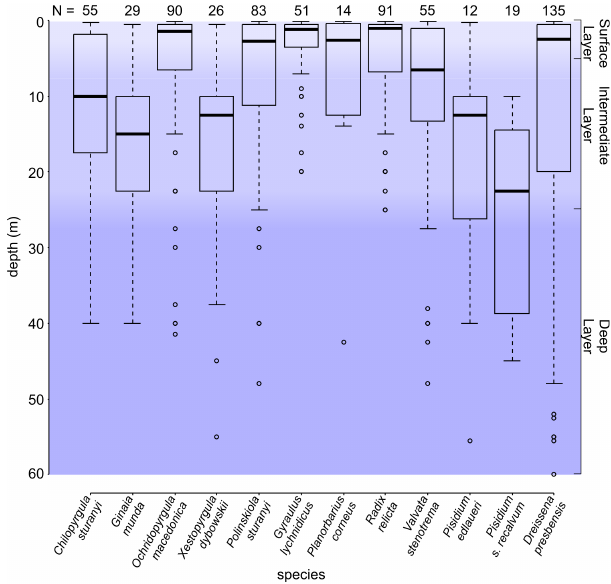
Fig. 5. Quartile box plots of observed depth ranges of recent mem- bers of the thanatocoenosis after balancing for unequal numbers of collection points. The 50% range of 11 of 12 species matches the depth range of the Intermediate Layer, where recent collecting points showed the highest similarity to the thanatocoenosis. The depth range of the Deep Layer was not covered by any of the species and the depth range of the Surface Layer by 6 of the 12 mollusc